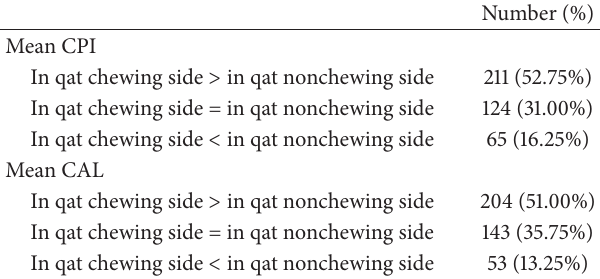
Table 4: Subject-level comparison of mean CPI and CAL in the qat chewing and nonchewing